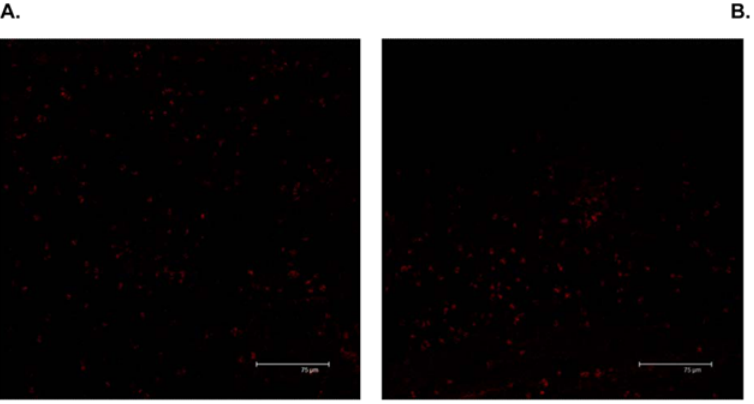
Figure 11. Fluorescence Detection of apoptotic cells. Panel A shows apoptotic cells (stained in red with the ApopTag kit) in a skin section of a mouse infested with a Ir-LBP siRNA-treated tick. Panel B shows apoptotic cells stained with the same technique in a skin section from a mouse infested with a siControlRNA-treated tick.